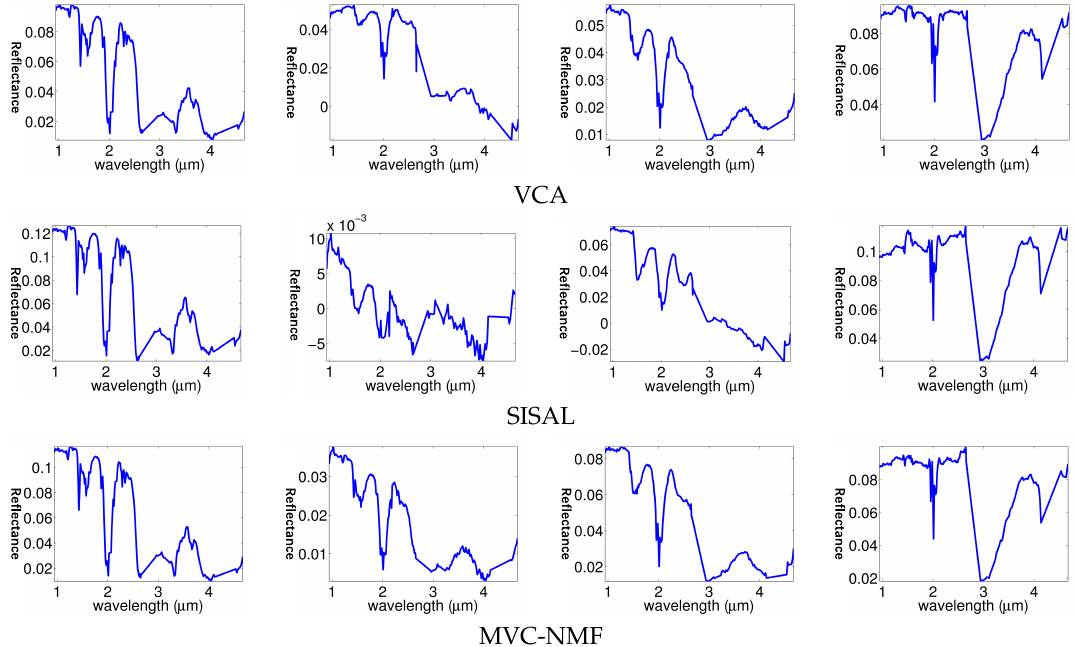
Figure 8. Spectra of the endmembers extracted, respectively, by VCA, SISAL and MVC-NMF from the ORB0041 image. The endmembers are sorted according to their chemical